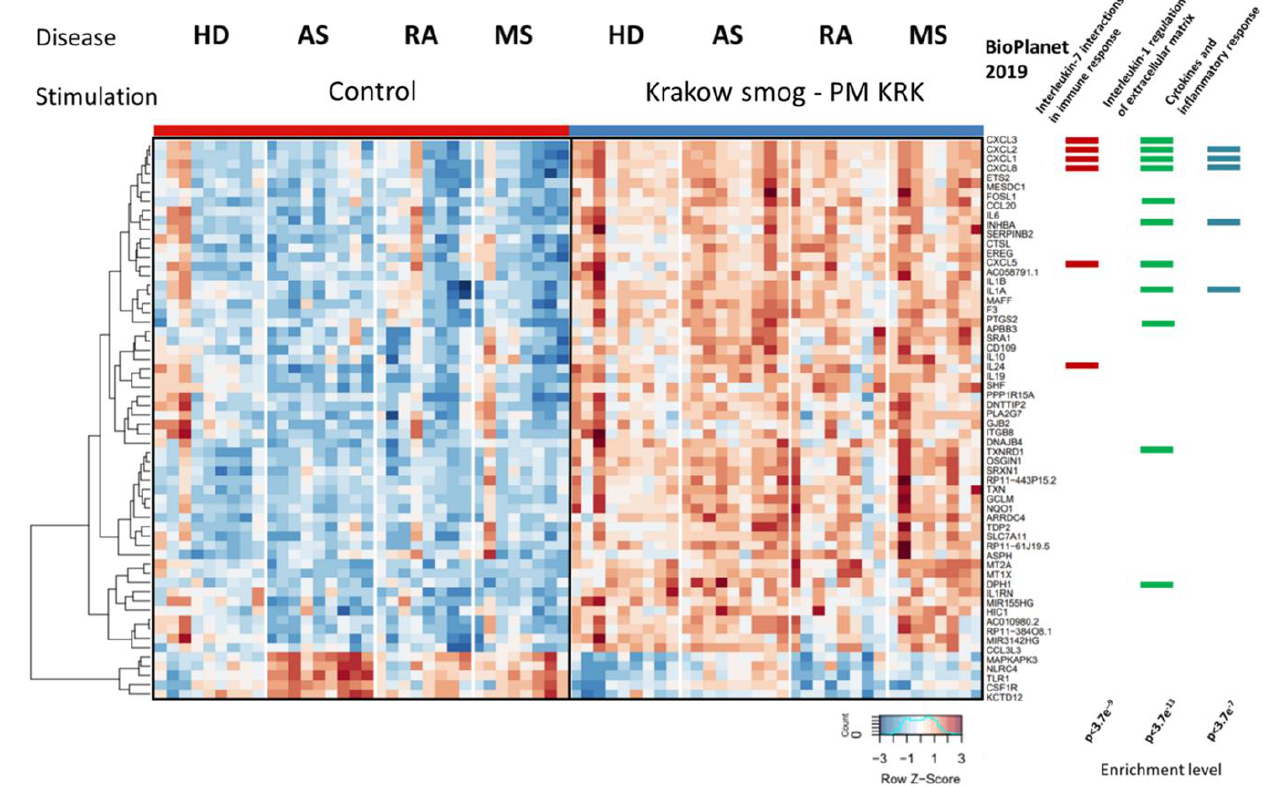
Figure 3. Gene expression alterations induced by PM KRK stimulation. The PBMCs-derived from healthy donors (HD), patients with atherosclerosis (AS), rheumatoid arthritis (RA), and multiple sclerosis (MS) were treated with PM KRK. RNAseq results are shown as a heatmap and include transcripts with a genome-wide significance from two-way ANOVA for the stimulation factor (FDR corrected p < 10 − 9 ) and the difference between the control and stimulation group (a fold of change log 2 > 1). The intensity of the coloured rectangles represents transcript abundance levels. The presented level is proportional to the row z-score values (between − 3 and 3) as displayed on the bar below the heatmap image. Hierarchical clustering was performed using correlation as a distance measure. The full list of differentially expressed transcripts is presented in Table S1. On the right panel, the results of the functional enrichment analyses performed with the Enrichr tool are presented. Three example over-represented pathways are based on BioPlanet 2019 dataset. The full list of enriched biological terms is presented in Table